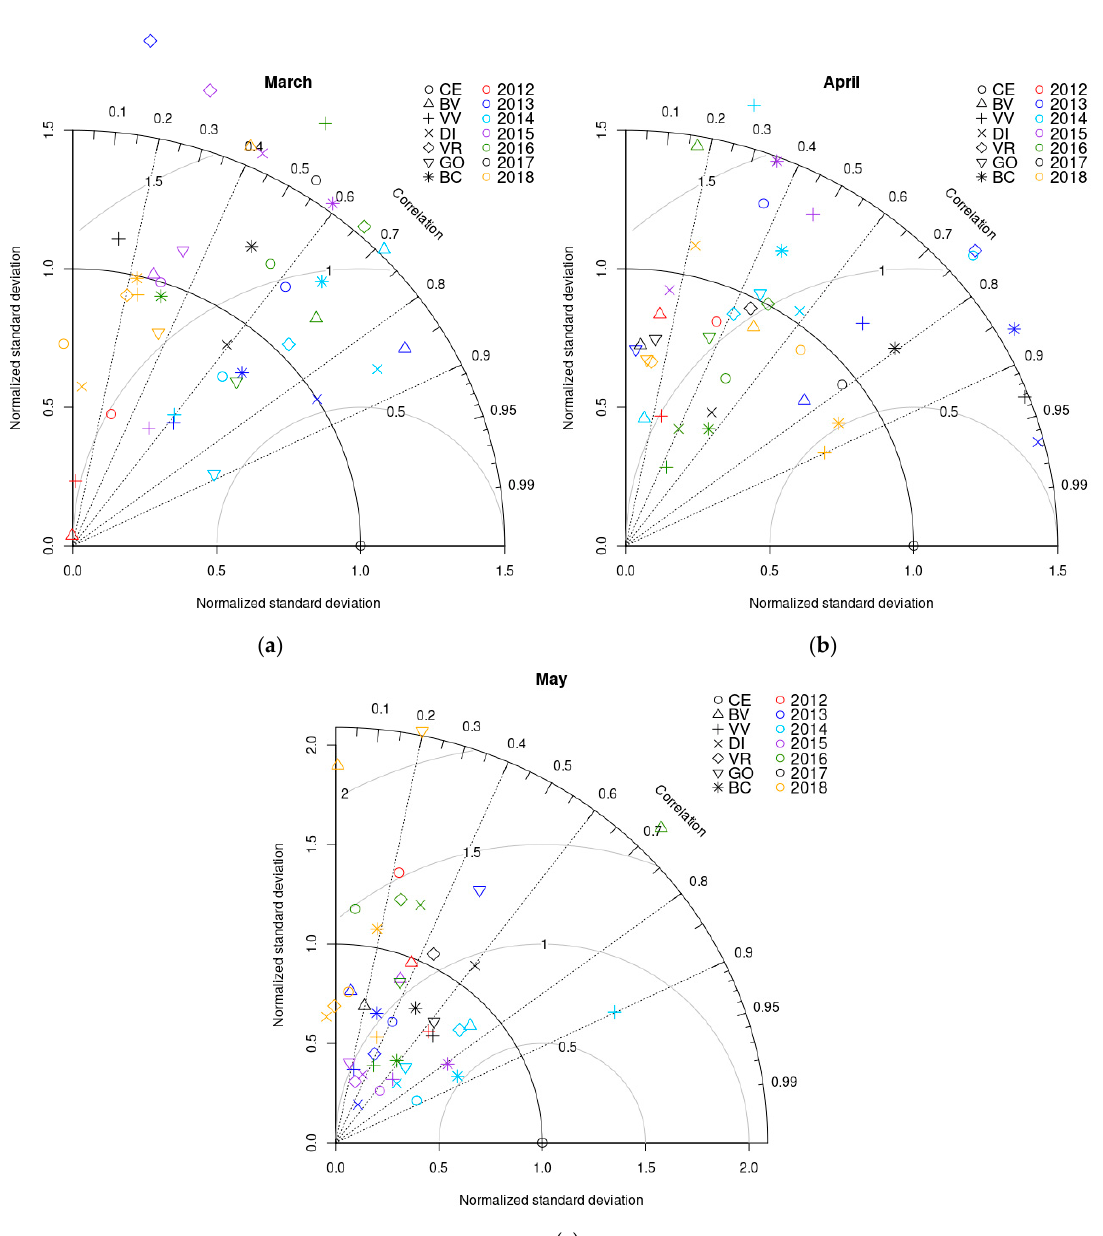
Figure 6. Taylor diagram for daily sum of precipitation for ( a ) March, ( b ) April, and ( c ) May at selected locations during 2012–2018.